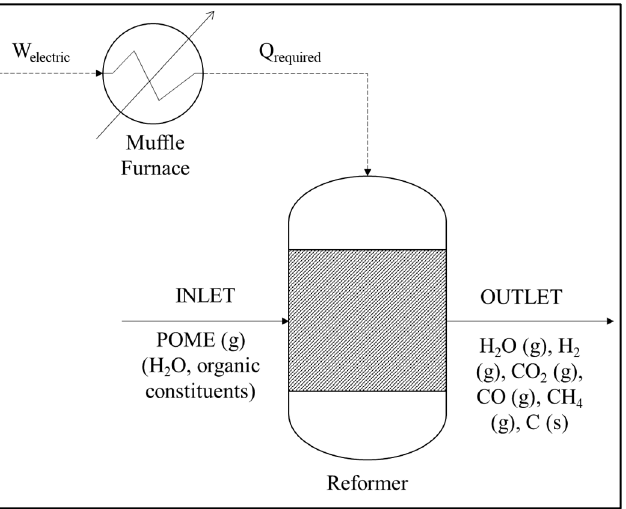
Figure 9. Process flow diagram of POME steam reforming. Adapted with permission from